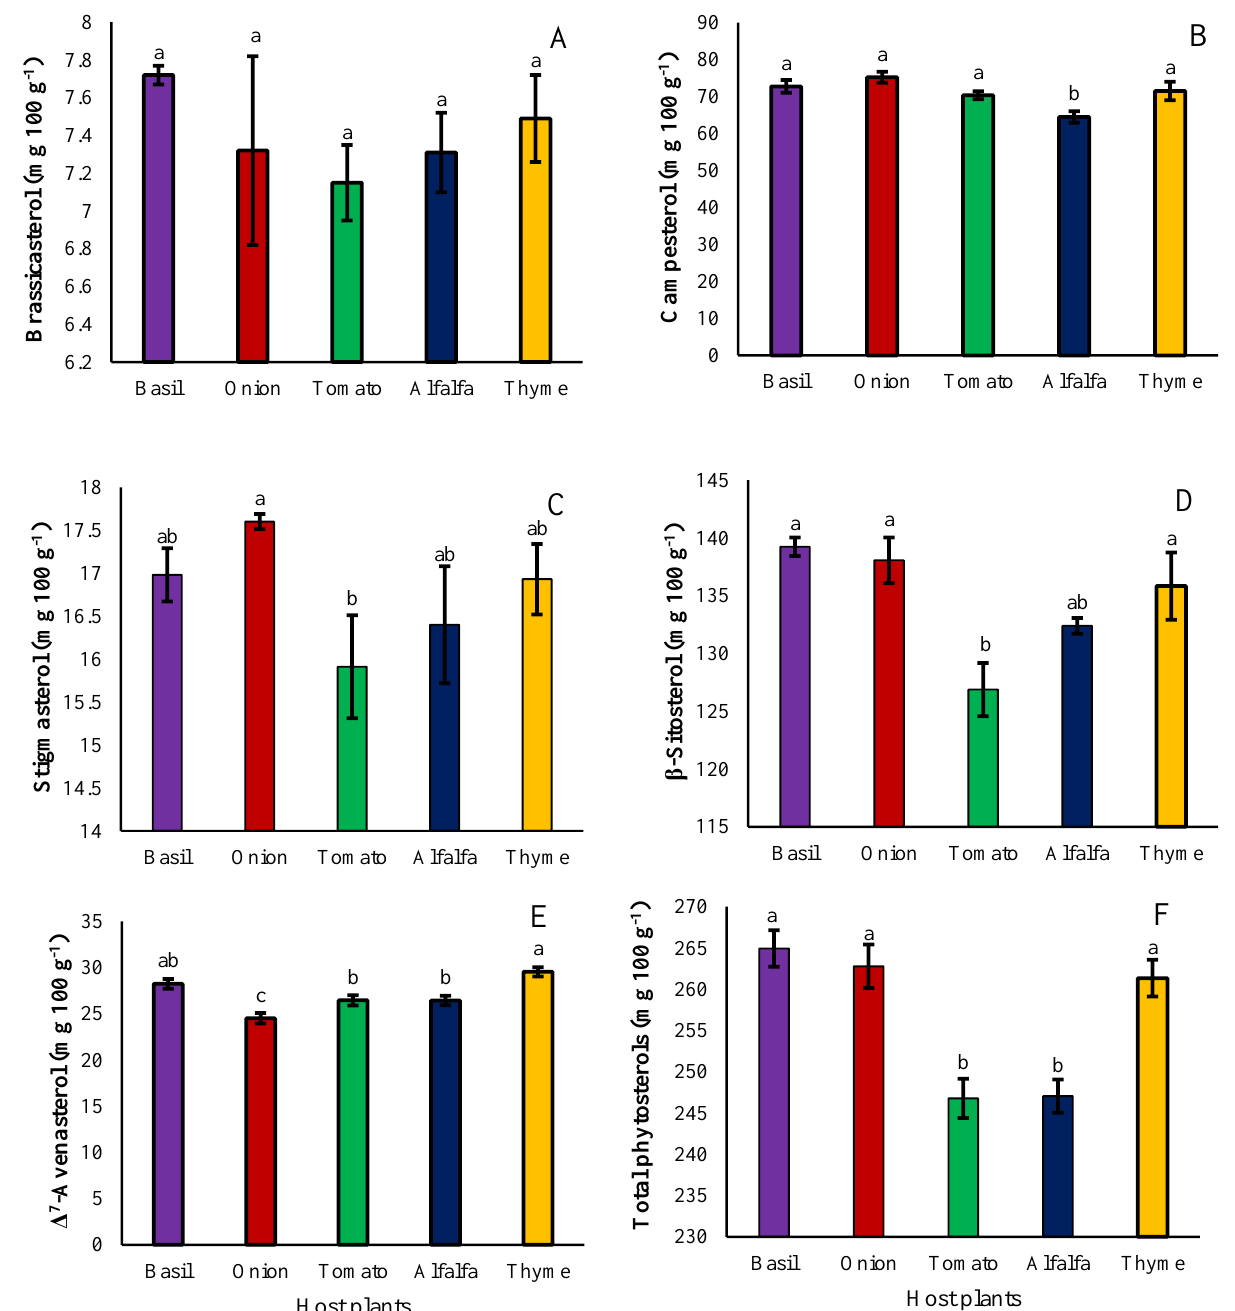
Figure 7. The effect of different hosts on brassicasterol ( A ), campesterol ( B ), stigmasterol ( C ), β- Sitosterol ( D ), ∆ 7 -Avenasterol ( E ), and total phytosterols ( F ) of the Cuscuta campestris seeds set on different hosts. Bars with the same lowercase letter are not significantly different at p ≤ 0.05 for n = 3.